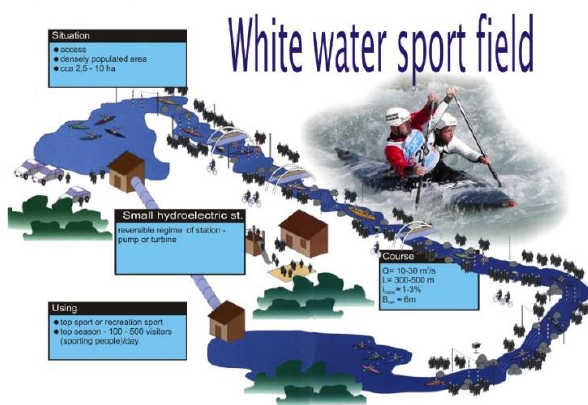
Figure 1. Basic description of whitewater